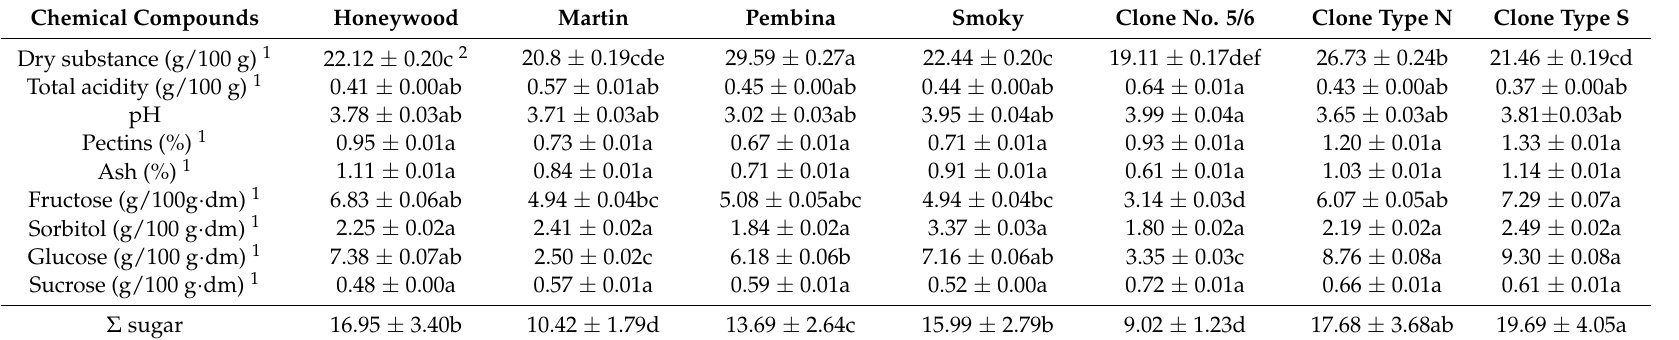
Table 1. Chemical composition of fruits in different Saskatoon berry genotypes analyzed in